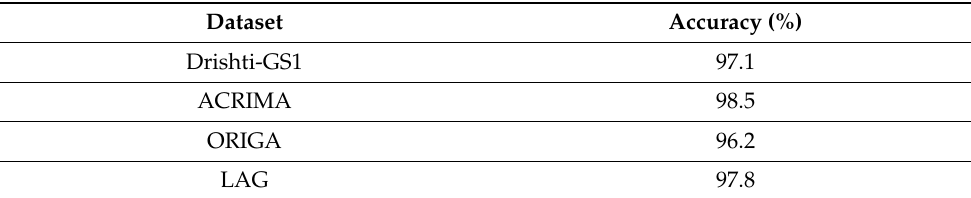
Table 8. 10-fold cross validation results.